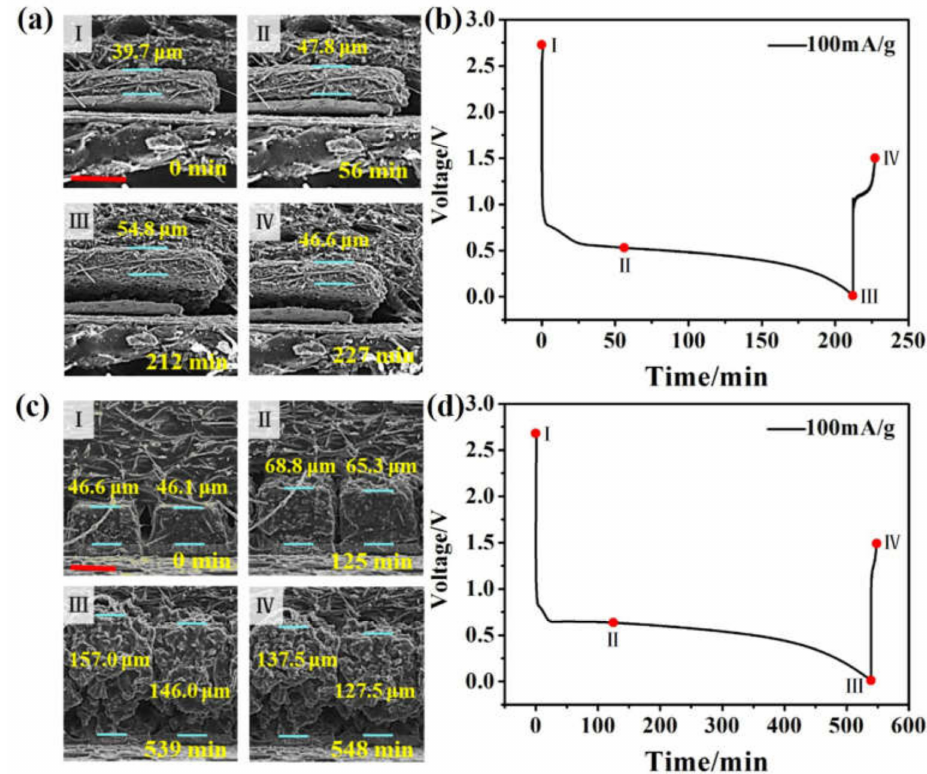
Figure 2. In situ SEM images of Si/C composites during charge and discharge processes. ( a ) The SEM images of unstructured Si/C composites were captured at the corresponding red points in ( b ) the galvanostatic charge–discharge curve (scale bar, 100 µ m). ( c ) The SEM images of 3D-line-structured Si/C composites were captured at the corresponding red points in ( d ) the galvanostatic charge–discharge curve (scale bar, 50 µ m). The curves were acquired at 100 mA/g in the voltage range of 0.01–1.5